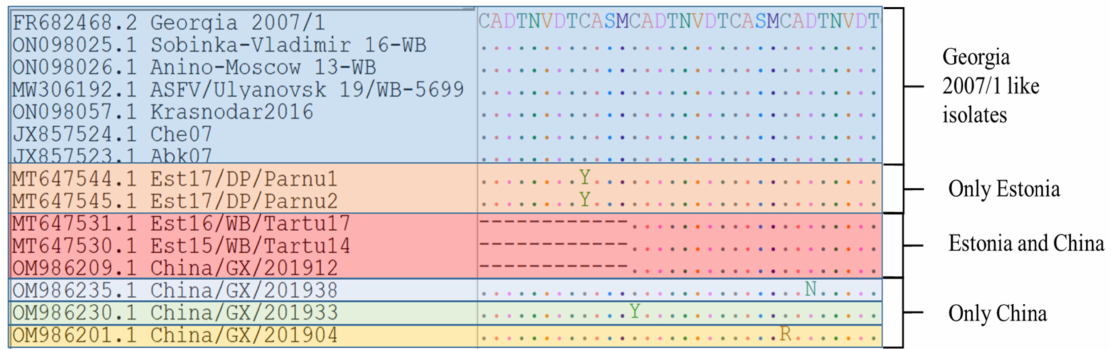
Figure 3. Amino acid sequence alignment of the tetrameric tandem repeat sequences (TRSs) of the central variable region (CVR) of the B602L